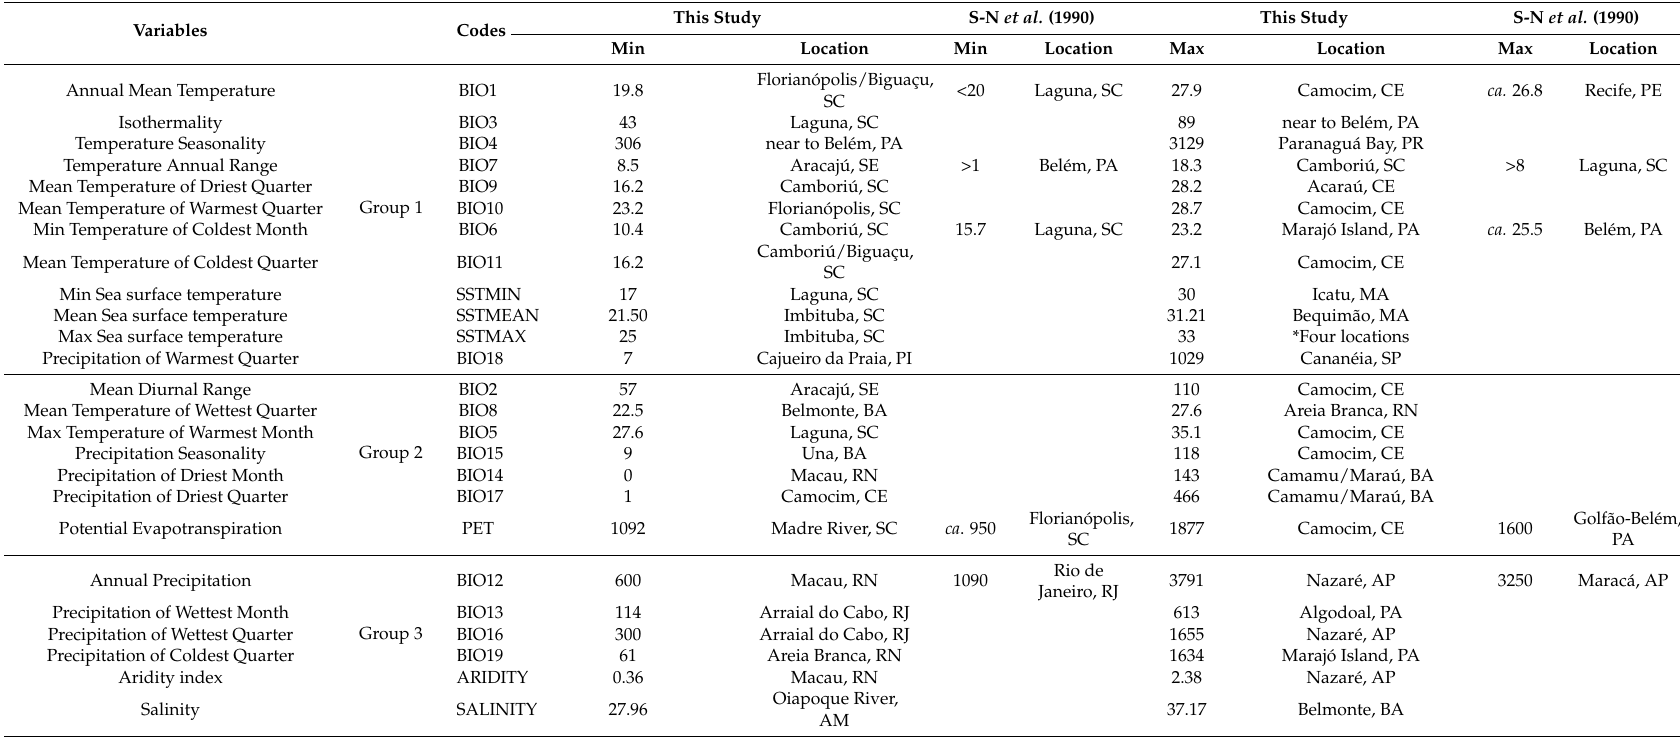
Table 5. Comparison of the minimum and maximum values of the environmental variables and their geographical location based on the results of Schaeffer-Novelli et al. [2] and the present study. * The maximum values of SSTMAX are found in four locations: Chaves, near to Bragança (PA) and two others locations in between São Luiz (MA) and Parnaiba